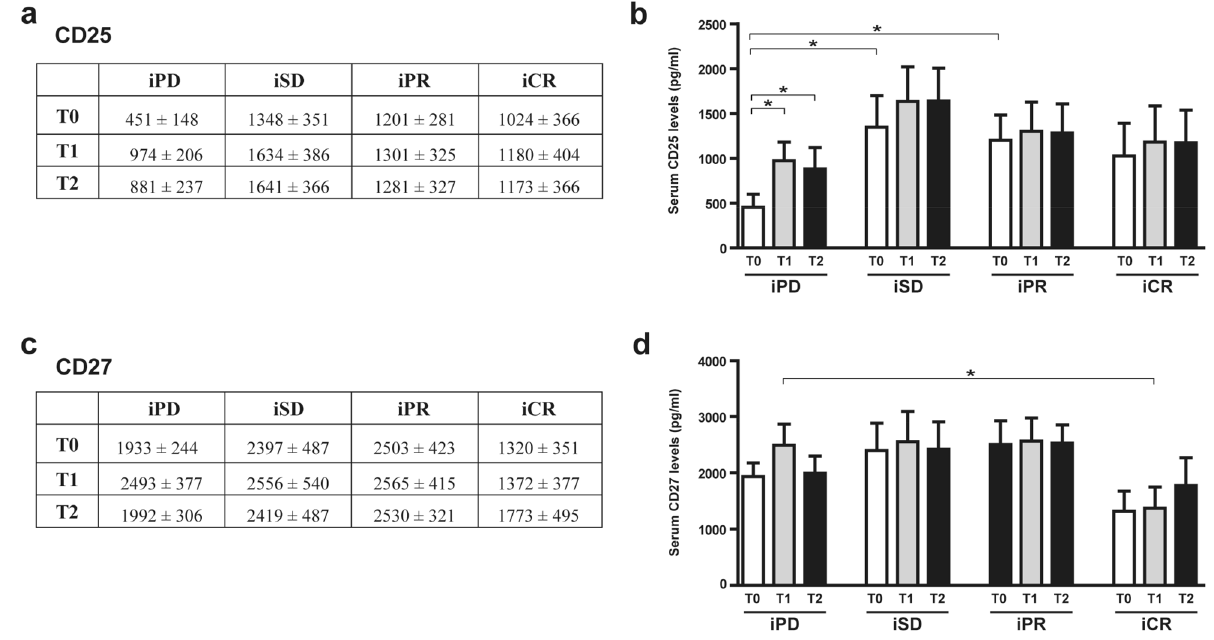
Figure 1. Serum levels of CD25 and CD27 in melanoma patients treated with CPIs. Protein amounts were analyzed by ELISA in serum samples of melanoma patients before (T0) and after 1 month (T1) or 3 months (T2) of treatment. Best overall response according to iRECIST criteria: iPD, progressive disease (n. 13 patients); iSD, stable disease (n. 16 patients); iPR, partial response (n. 17 patients); complete response, iCR (n. 11 patients). ( a , b ) CD25, ( c , d ) CD27 amount (pg/ml). Data are expressed as mean value ± standard error of the mean (SEM). * p < 0.05, as assessed by Mann–Whitney U test to compare between-group differences; or by Wilcoxon signed- rank test to evaluate before-after treatment